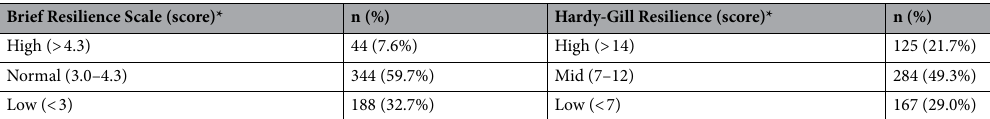
Table 3. Resilience level of participants. *Detailed items of the scales with the scoring are provided in the supplementary